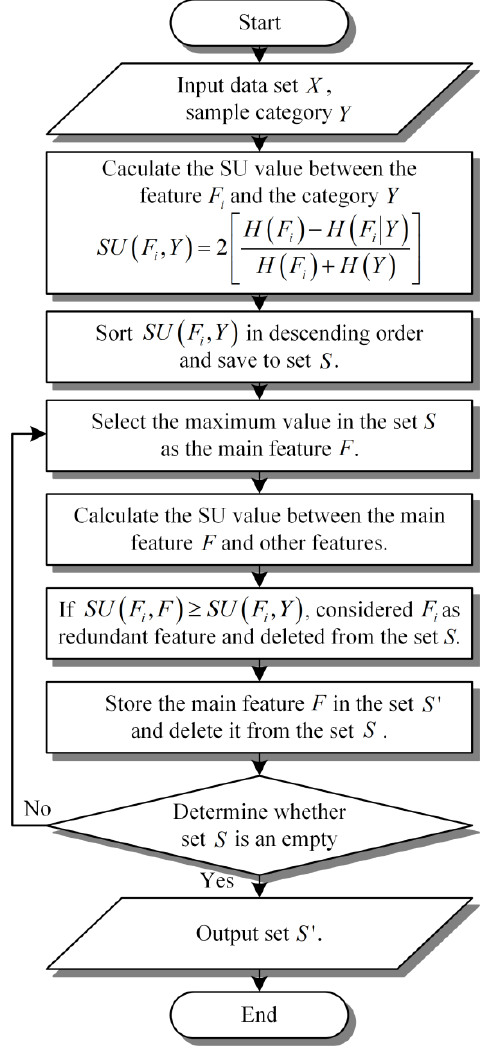
Figure 6. The flow chart of